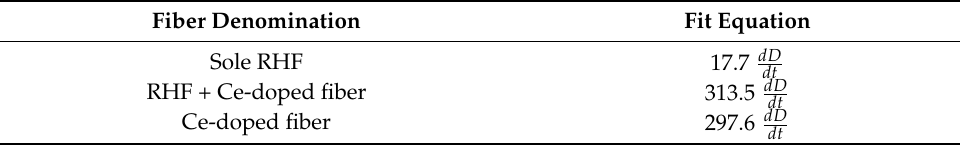
Table 1. Fit parameters used for the fit on data for each